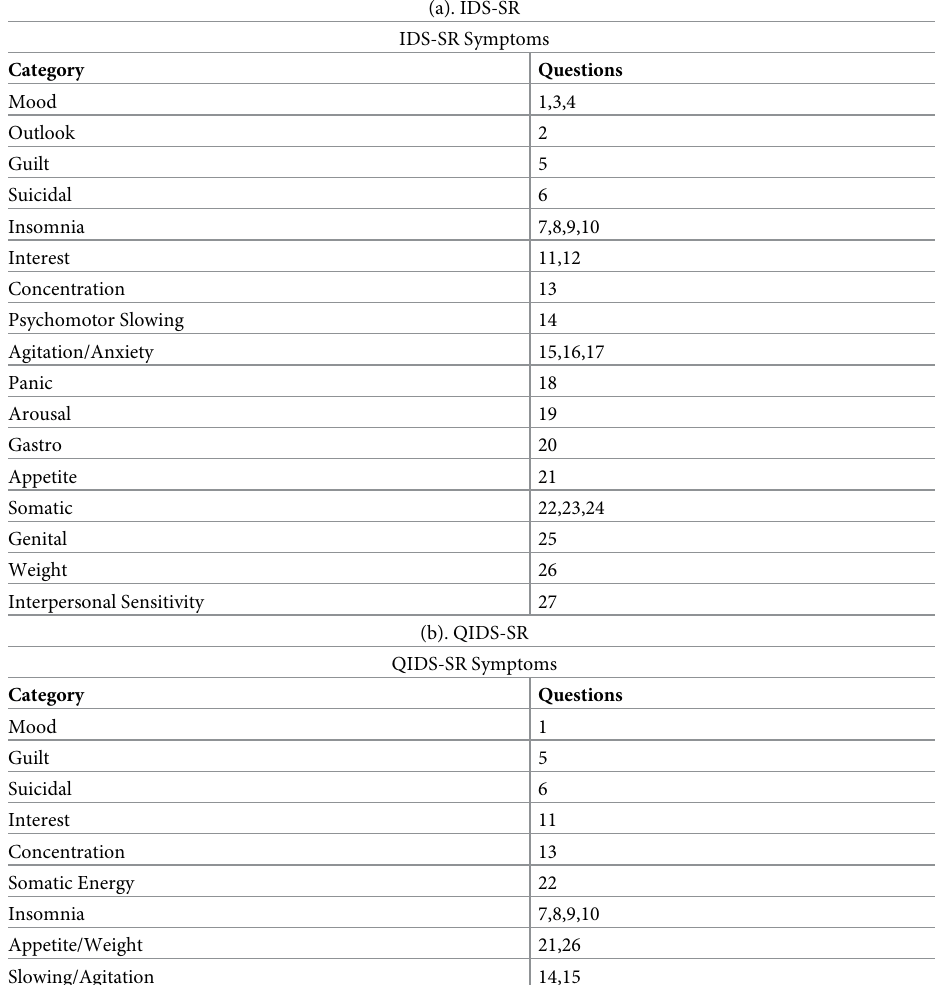
Table 5. Symptoms categories and relevant questions of scoring systems.